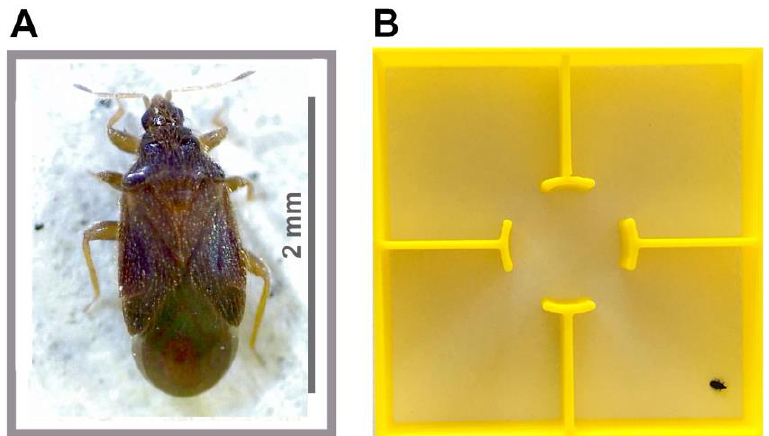
Figure 1. Embiophila myersi adult and arena for testing. ( A ) Imago, dorsal view. ( B ) 3D printed testing arena including one individual.